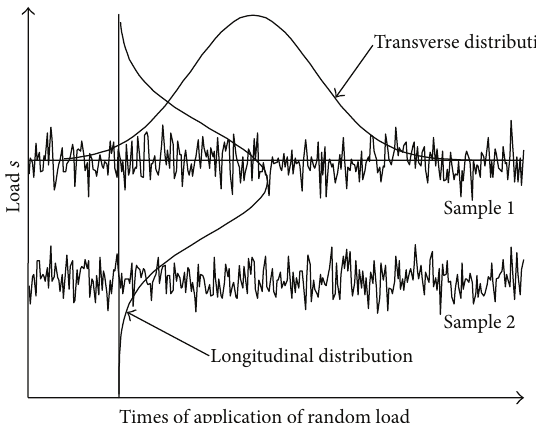
Figure 1: The schematic illustration of the LSI model. Figure 2: The schematic illustration of the distributions of the random